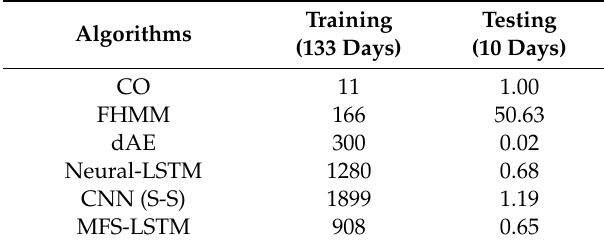
Table 6. The FHMM algorithm was the second-fastest followed by the dAE algorithm. Training time results show that the proposed MFS-LSTM algorithm has faster execution time than the neural-LSTM and CNN(S-S) because of the fewer parameters and relatively simple deep RNN architecture. Table 6. Computation time comparison between disaggregation algorithms (in